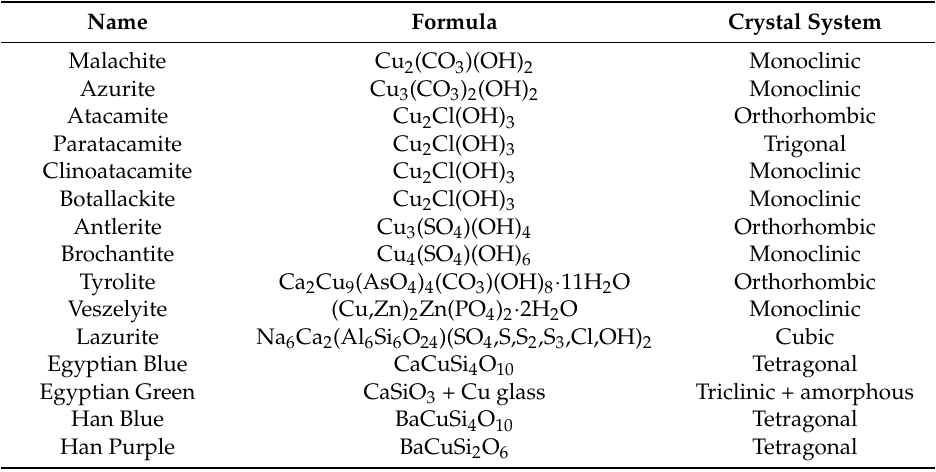
Table 3. Blue and green mineral pigments and synthetic analogues important in archaeological contexts.